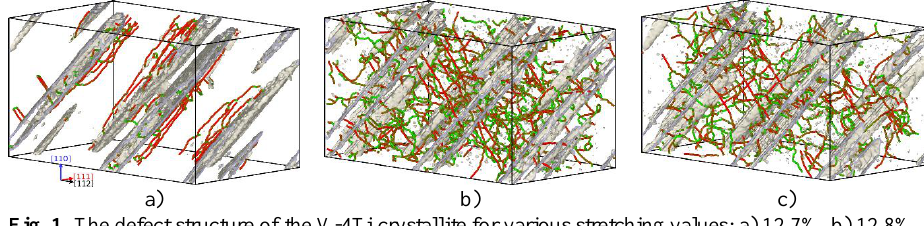
Fig. 1. The defect structure of the V-4Ti crystallite for various stretching values: a) 12.7%, b) 12.8%, c) 15.0%. The gray surfaces are twin boundaries, the red and green lines are screw and edge dislocations. Strain rate is 10 7 s